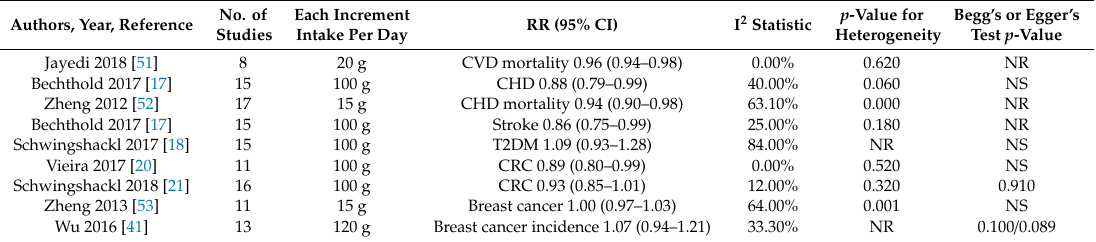
Table 9. Summary of linear dose-response meta-analyses of prospective studies on fish intake and CVD, CHD, stroke, T2DM, CRC, breast